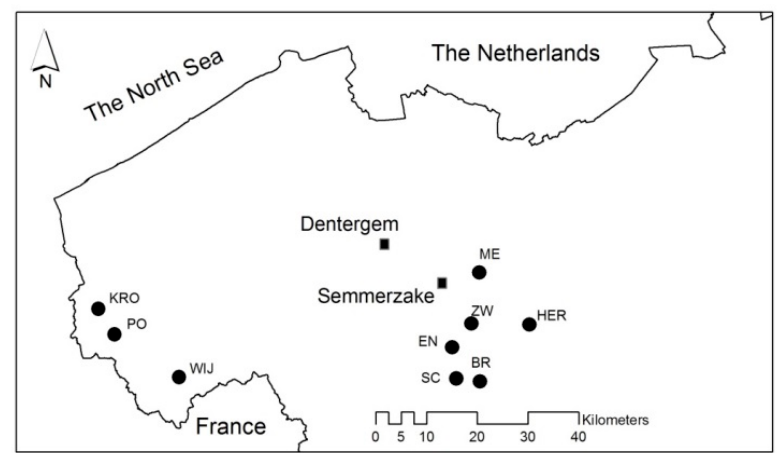
Figure 1. Map displaying the location of the nine natural populations of Prunus padus L. that were sampled (circles) and the location of the two common gardens Dentergem and Semmerzake (squares). Abbreviations of populations are in Table 1. Table 1. Genotypes of Prunus padus L. that were sampled in natural populations in the northern part of Belgium and vegetatively propagated, and the number of ramets that were planted in the two common gardens at Dentergem (n D ) and Semmerzake (n S ).